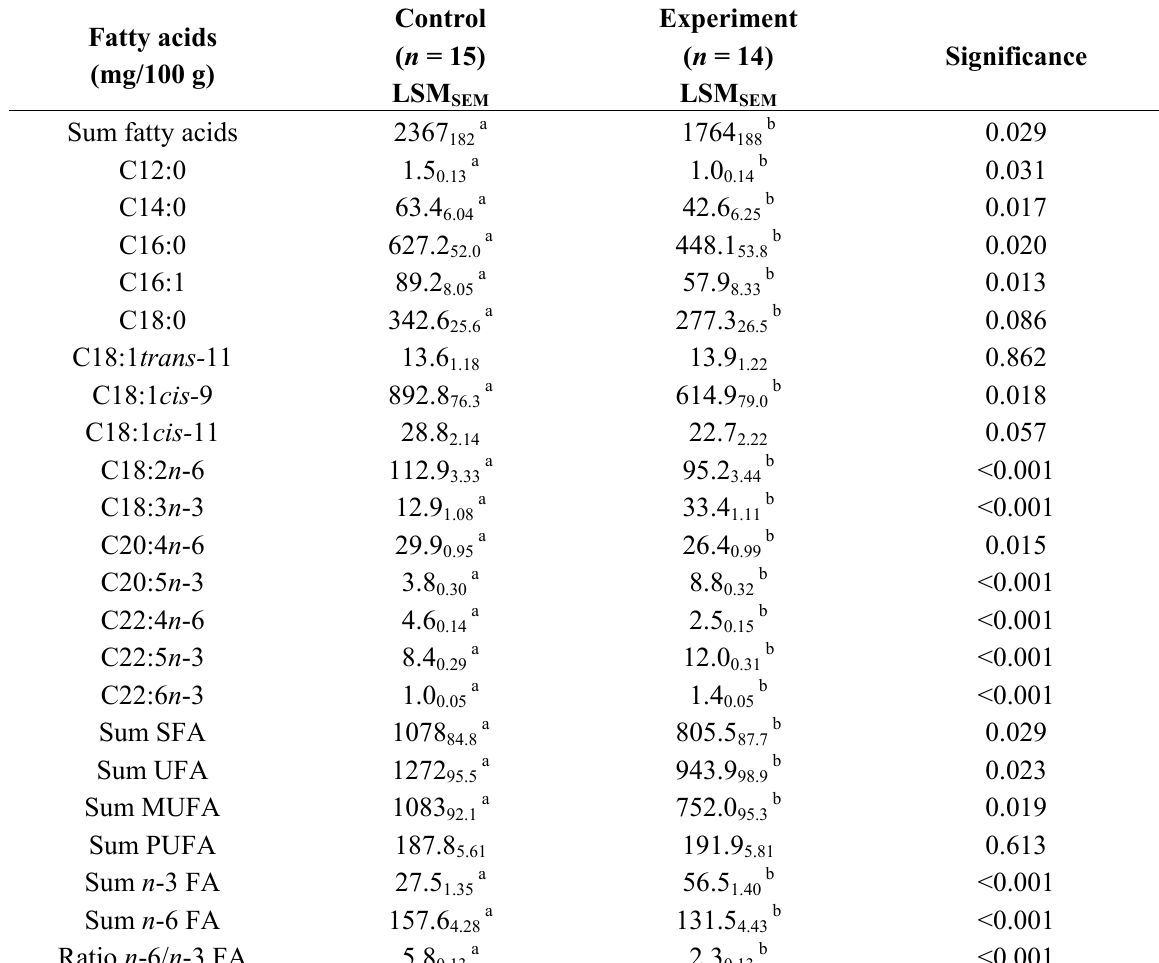
Table 1. Fatty acid concentration (mg/100 g) in Longissimus muscle of German Holstein bulls fed a different diet